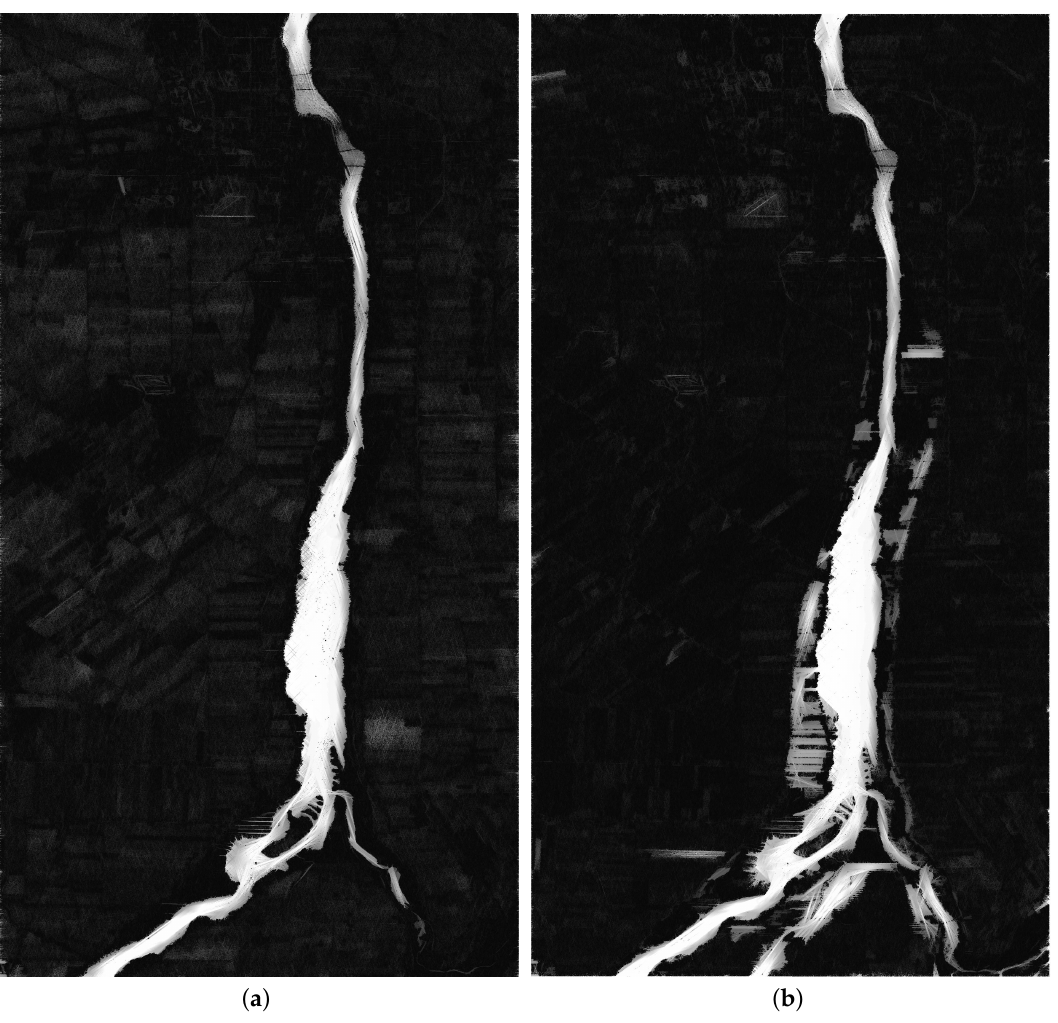
Figure 4. Result of the SFS-SD texture measurement application (site 1). ( a ) Result of the SFS-SD texture measurement applied to the pre-flooding image; ( b ) Result of the SFS-SD texture measurement applied to the post-flooding